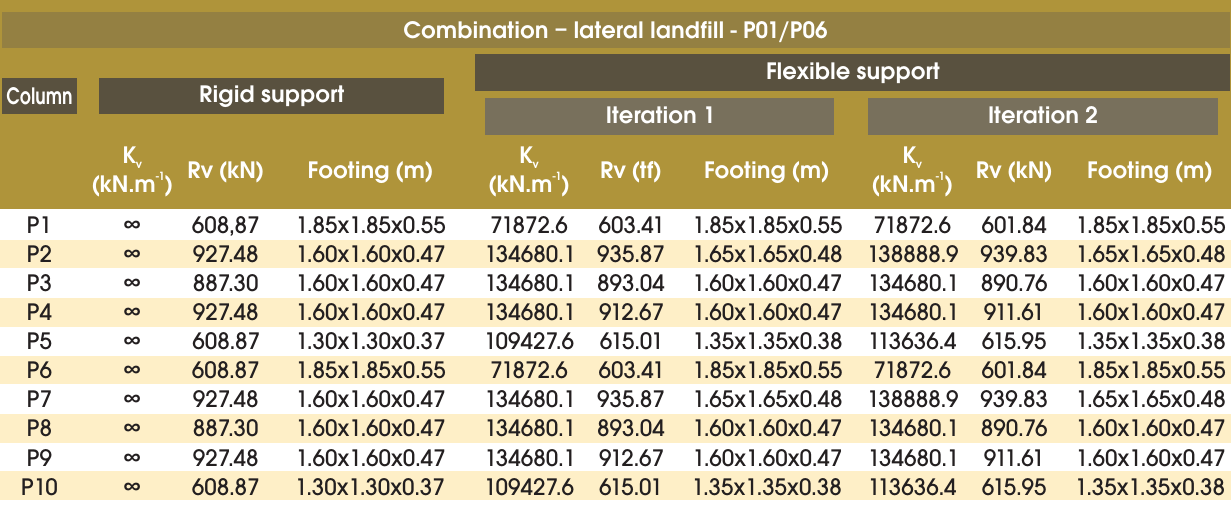
Table 5.4 – Stiffness, coefficients, reactions and foundation